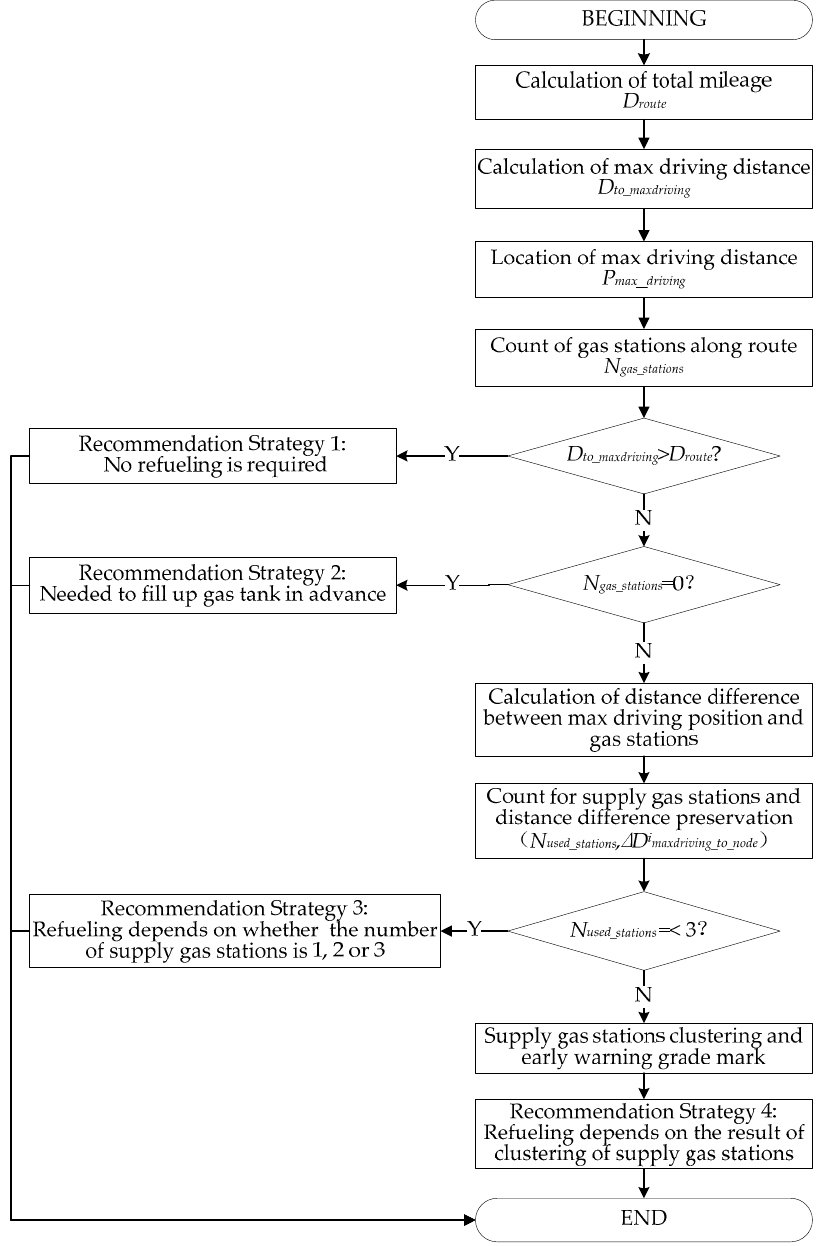
Figure 2. Procedure of the refueling recommendation algorithm.